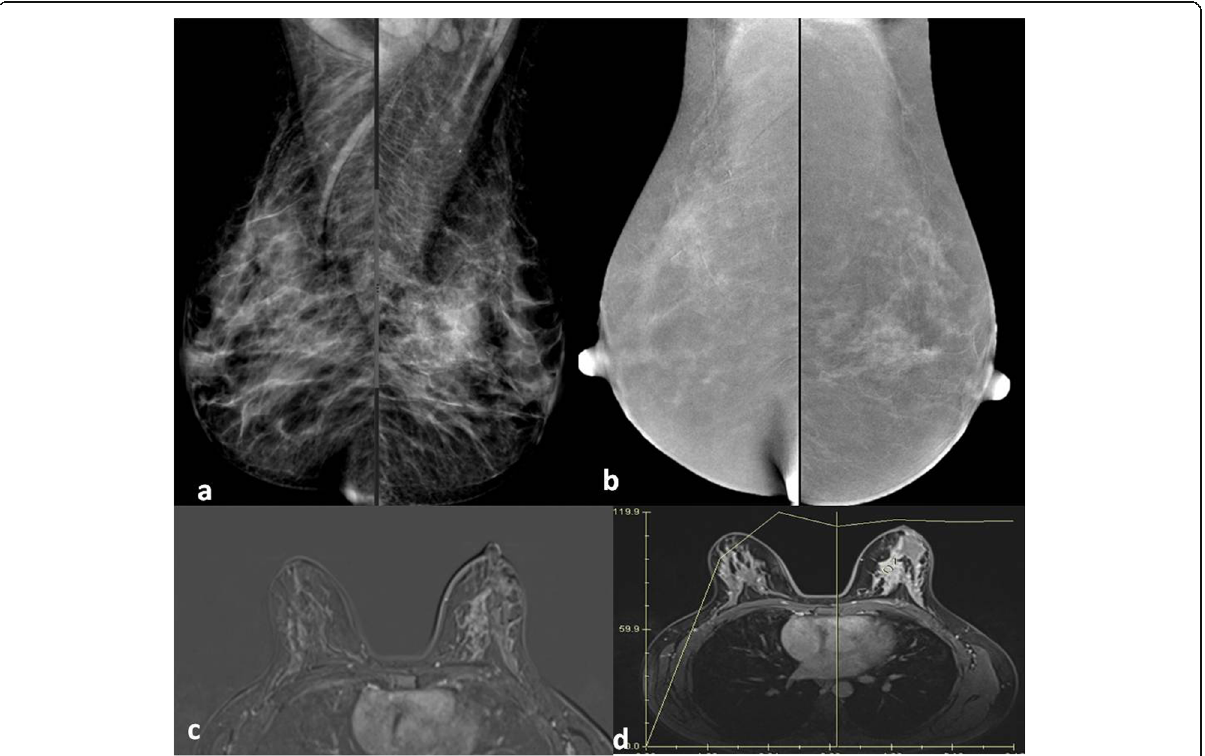
Fig. 2 Thirty-eight-year-old patient came for screening, SM revealed left upper inner quadrant (UIQ) focal asymmetry with overlying concomitant microcalcific clusters ( a ). CEM showed left UIQ focal asymmetry with overlying concomitant microcalcific clusters ( b ). MRI showed left breast segmental heterogeneous non-mass enhancement; on plotting time signal intensity curve, it showed type 2 (plateau curve) ( c , d ). The final diagnosis was ductal carcinoma in